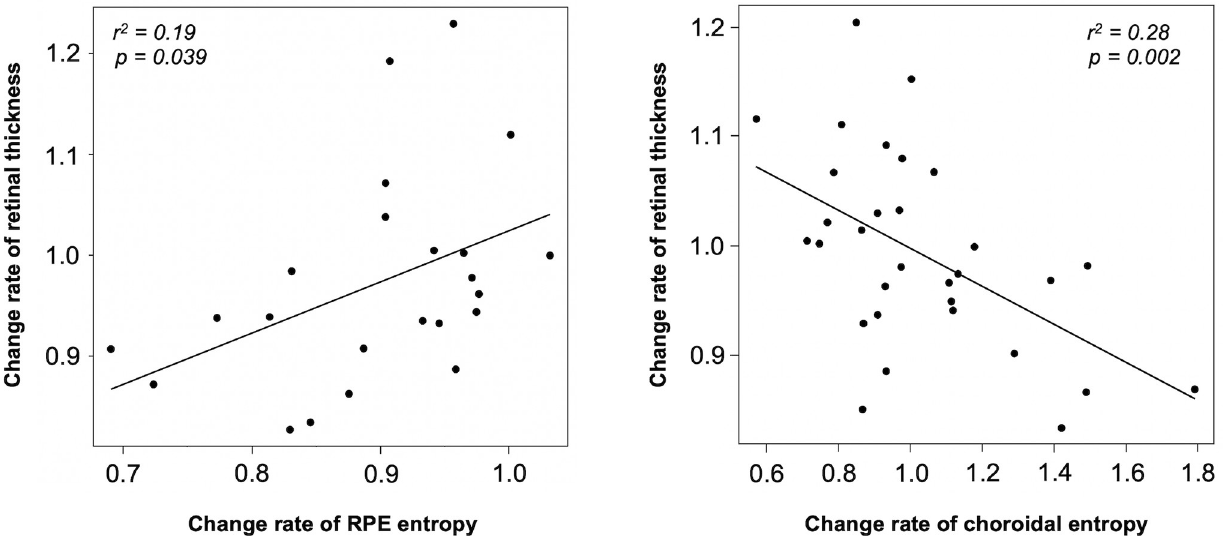
Fig 8. Relationship between the rate of change of retinal thickness and that of entropy value in SMPL-irradiated sectors. There was a positive correlation between the change rate of retinal thickness and that of entropy in the RPE at 6 months after SMPL (n = 9; r 2 = 0.19, P = 0.039). On the contrary, there was a negative correlation between the change the rate of retinal thickness and that of entropy in the choroid at 3 months after SMPL (n = 11; r 2 = 0.28, P = 0.002).